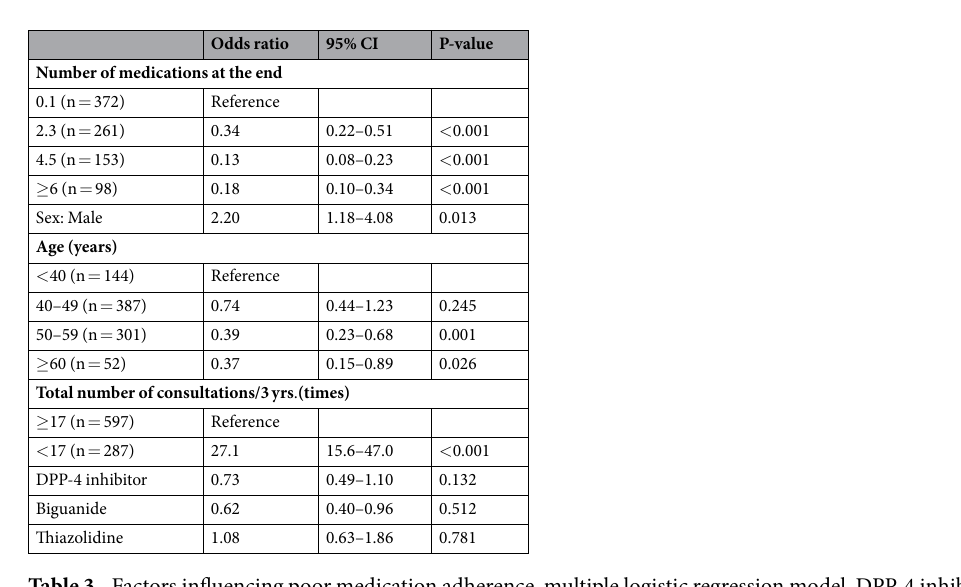
Table 3. Factors influencing poor medication adherence, multiple logistic regression model. DPP-4 inhibitor, dipeptidyl peptidase-4